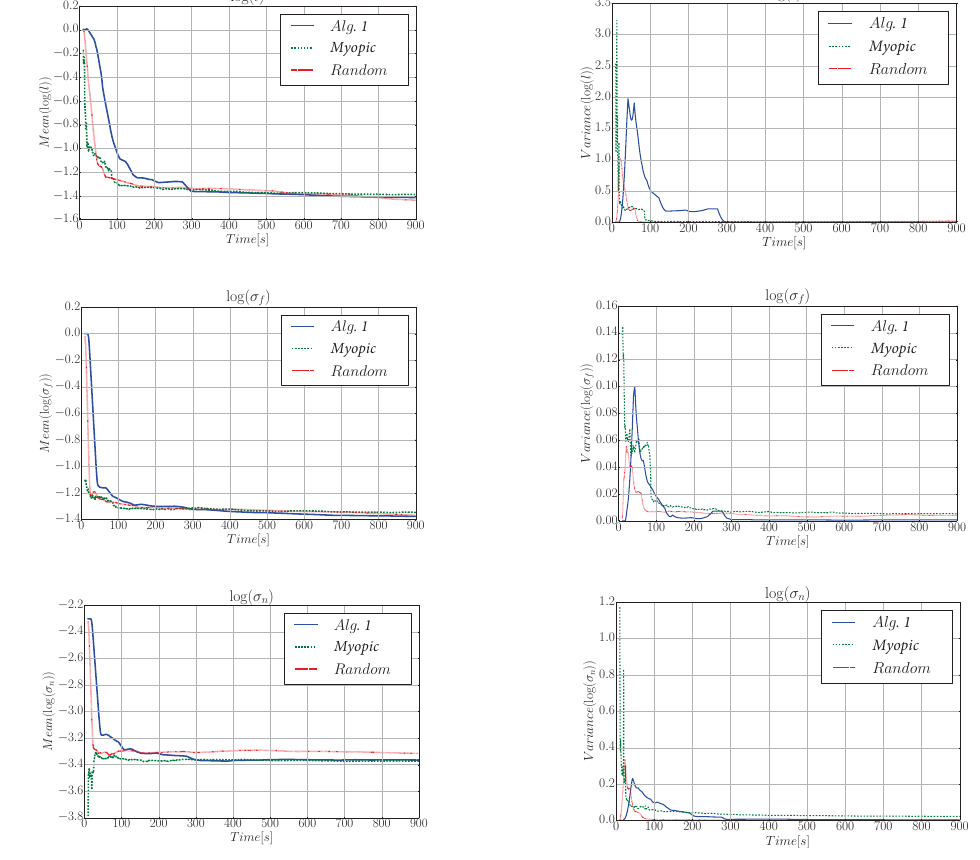
Figure 8. GPs hyperparameters learned during the information gathering task for Algorithm 1, a myopic, and a random trajectory. We represent the mean and variance over the 40 simulation runs. We show the hyperparameters θ = [ σ 2 , l , σ 2 n ] T f